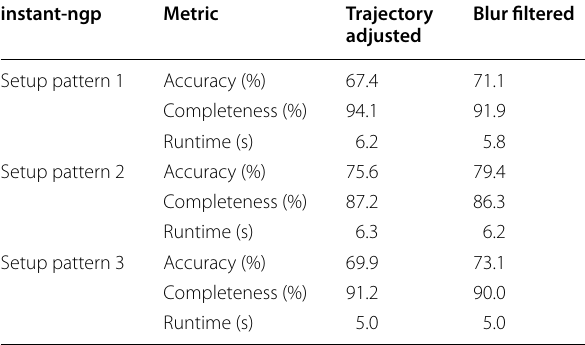
Table 8 Reconstruction performance comparison results by instant-ngp before and after blur filtering under three setup patterns instant-ngp